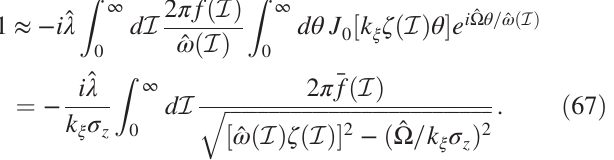
4.6 MV rf 352.06 MHz rf